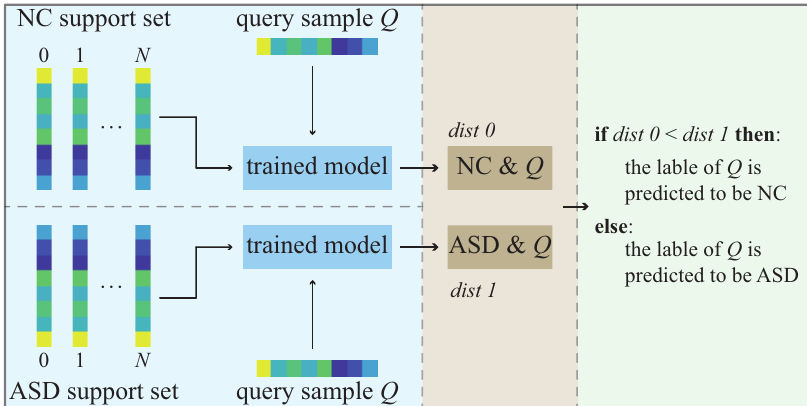
Figure 3. Test flowchart of the Siamese